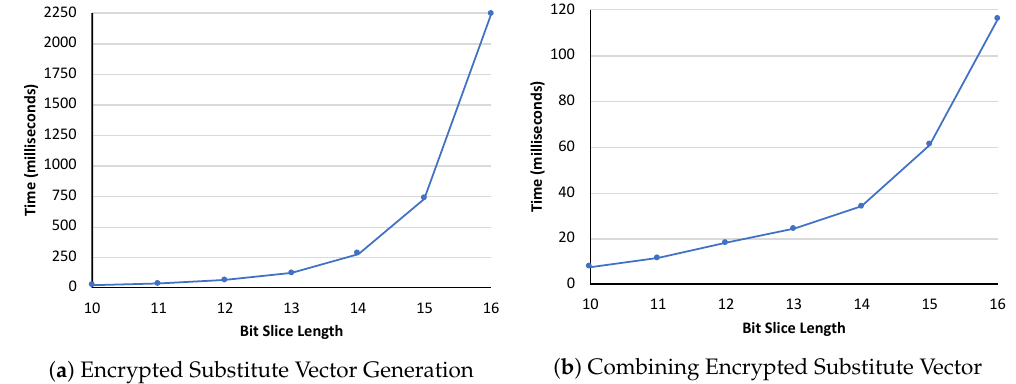
Figure 4. Bit-slice length effect on encrypted substitute vector generation